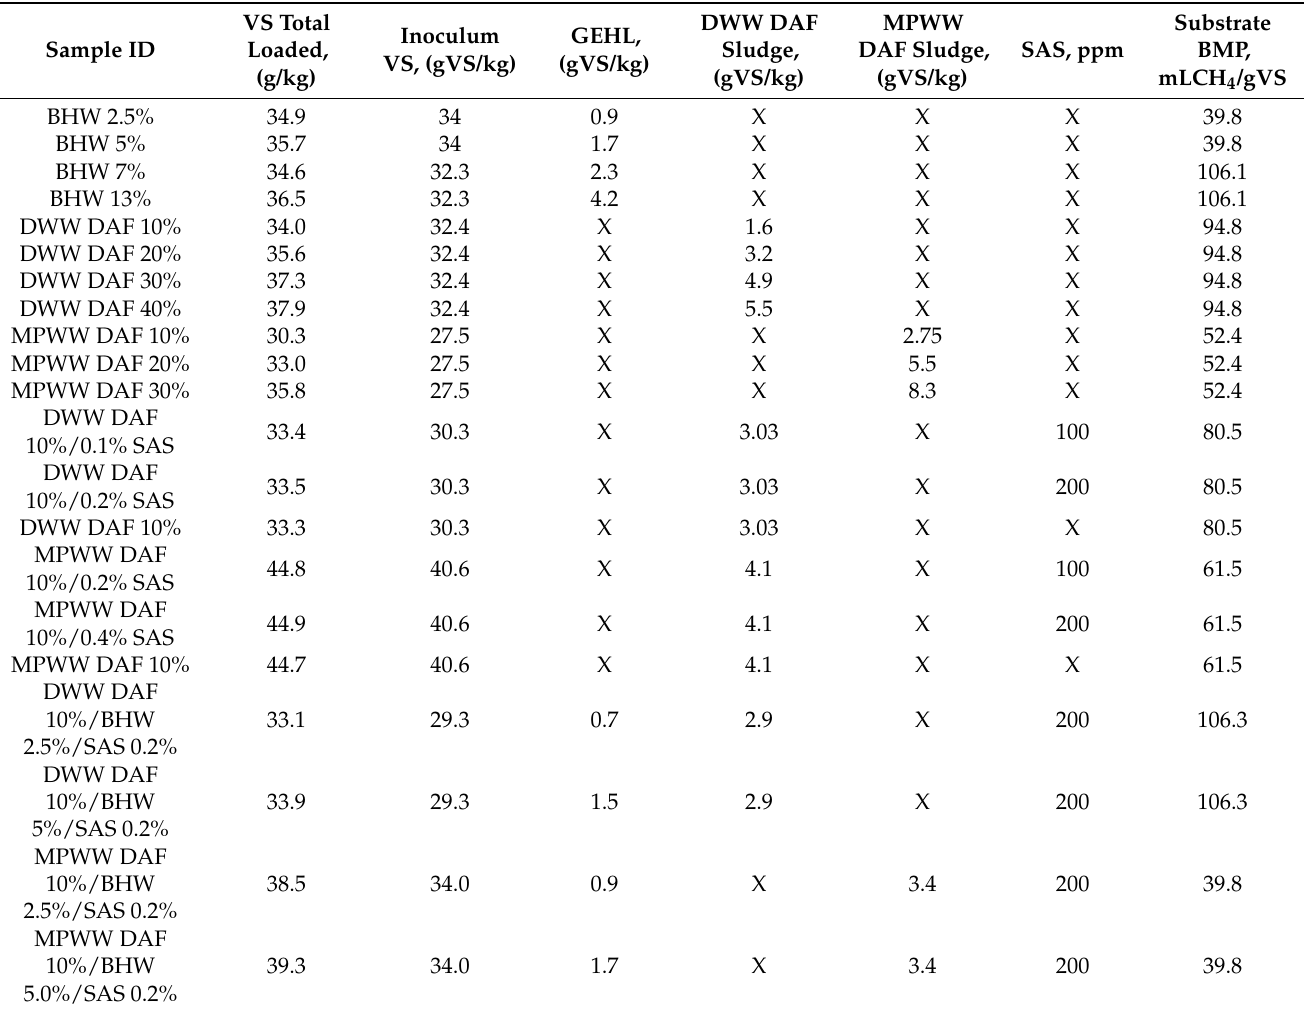
Table 3. AD sample loading and sample ID for all experiments performed. DWW